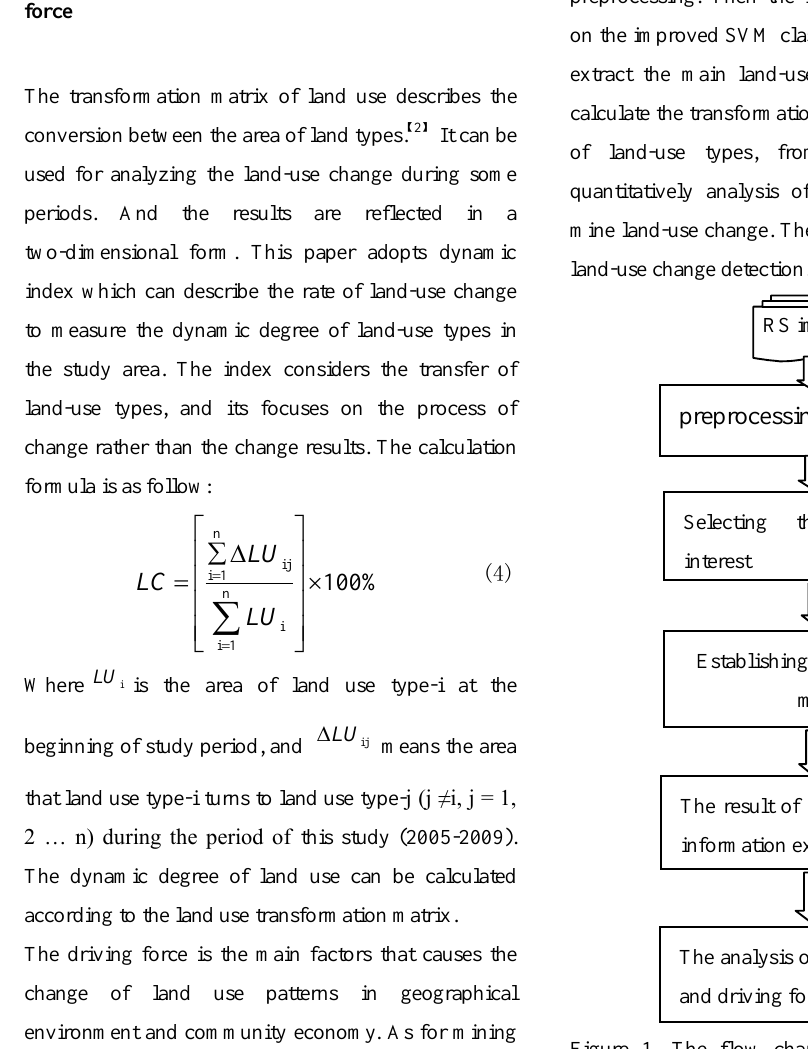
Figure 1. The flow chart of the land use